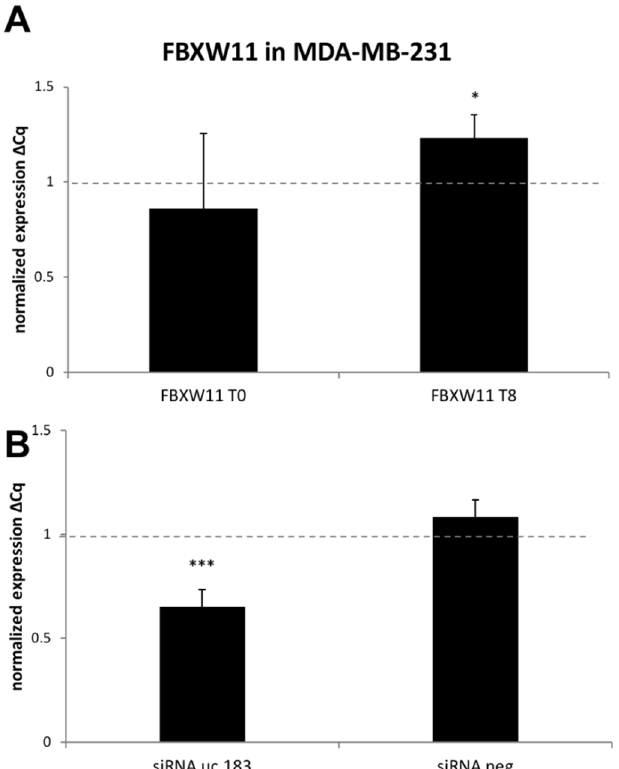
Figure 4. RT-qPCR analysis of FBXW11 mRNA in synchronized MDA-MB-231 cells. ( A ) FBXW11 mRNA levels evaluated at T0 (release from double thymidine block) and T8 (8 h after release). ( B ) FBXW11 mRNA levels analyzed in silenced cells with siRNA against uc.183 or siRNA negative con- trol. The values were expressed as log2 fold changes quantified using 2 −Δ Cq formula with respect to control. Statistical significance was determined by standard two-tailed Student t -test, p -value < 0.05 (*), p -value < 0.001 (***), derived from n = 4 independent replicates.